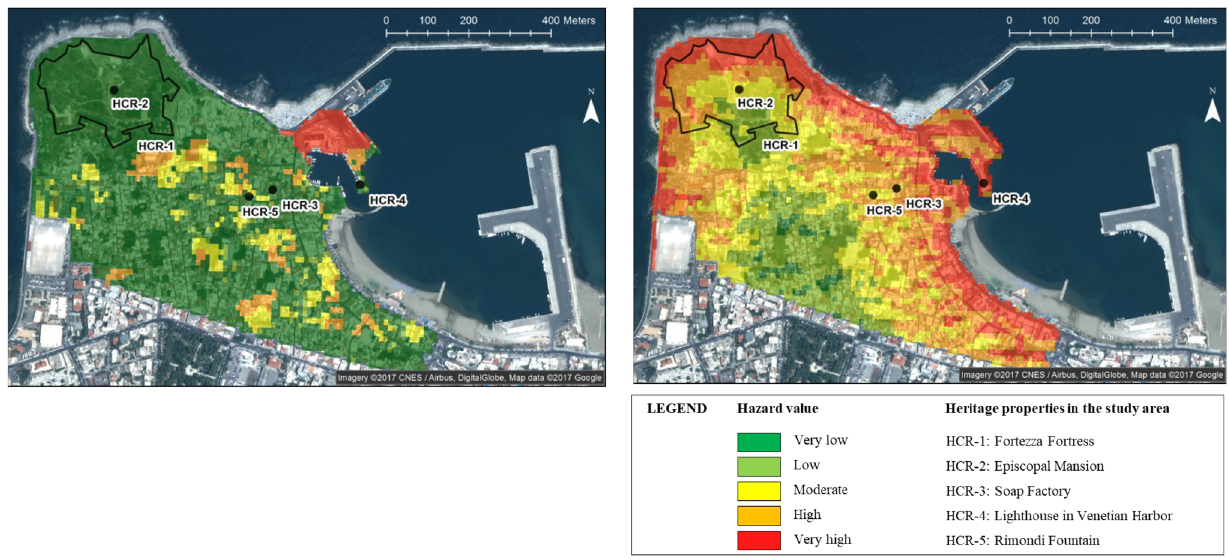
Fig. 6 Left: Flash flooding hazard map for the site area in Rethymno, Crete, Greece representing likelihood of flooding areas; Right: Salinization hazard map for the site area representing corresponding ground